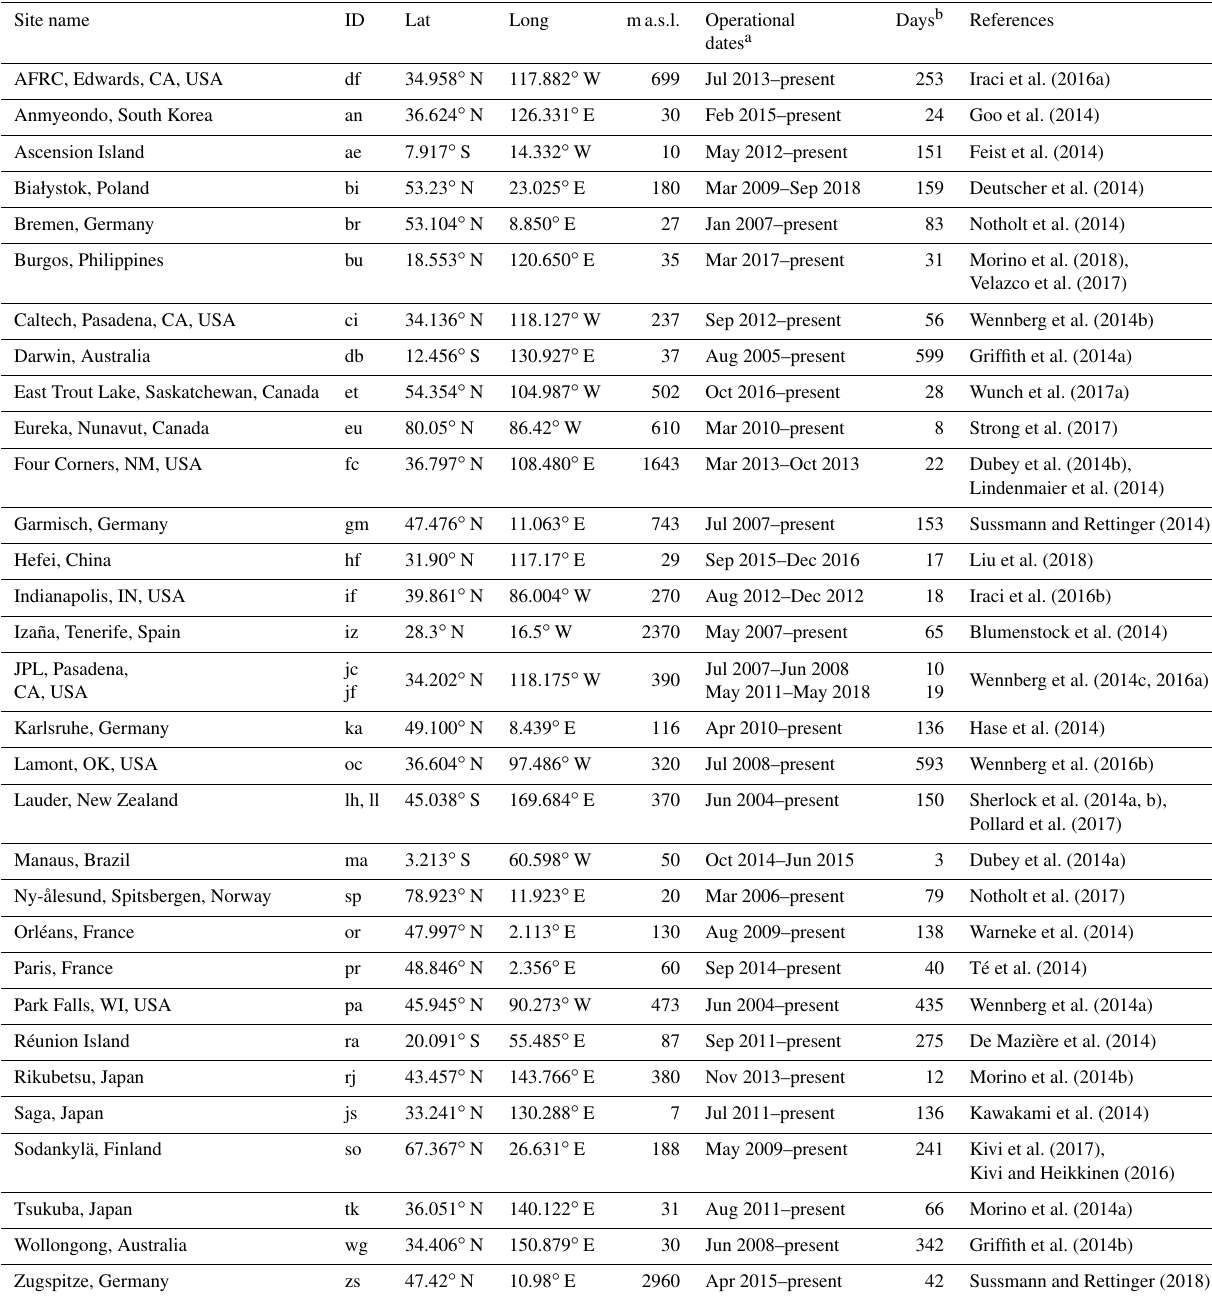
Table 1. Details for TCCON sites used in this study. Occasionally one site had more than one instrument, as indicated by multiple two-letter